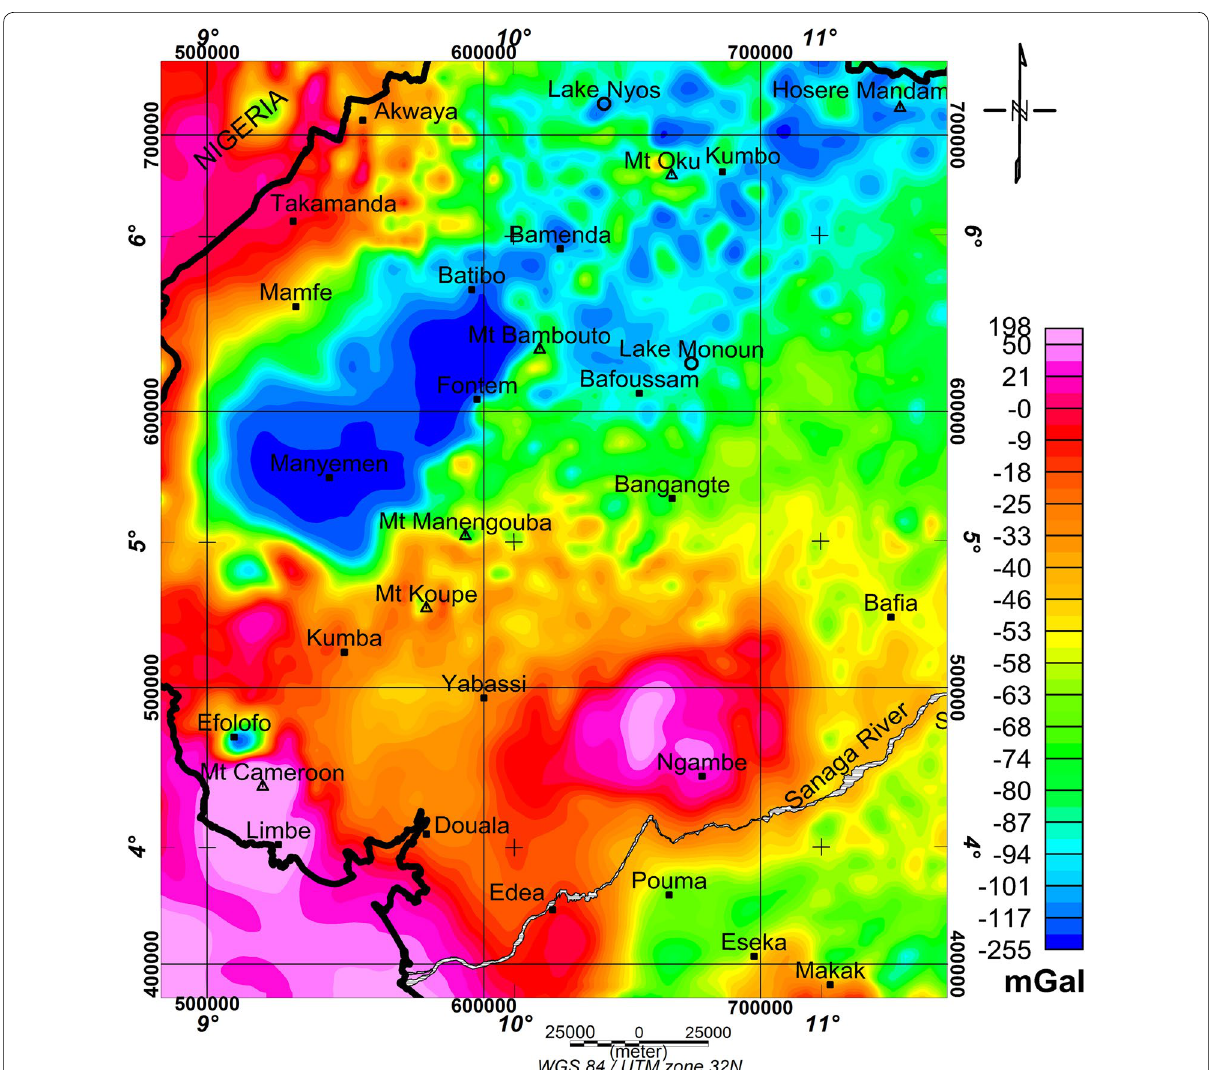
Fig. 4 Bouguer anomaly map derived from EGM2008 of the study area (modified from Marcel et al.